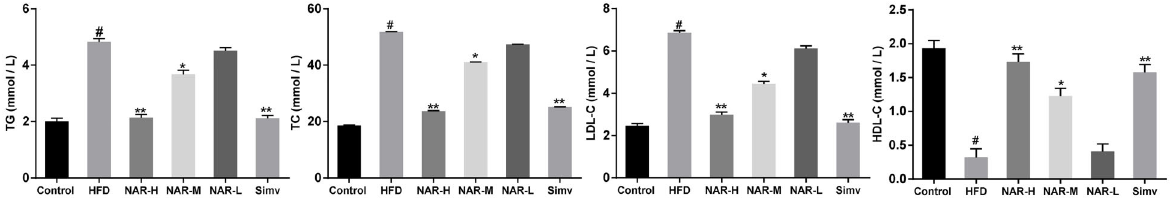
Figure 1. NAR reduced the TG, TC, and LDC-C levels but enhanced the HDL-C level in serum in HFD-induced atherosclerosis ApoE – / – mice. Data are reported as mean ± SD. # P o 0.01, *P o 0.05 compared to the control group; **P o 0.01, compared to the HFD group; n=8 (ANOVA). NAR: naringenin: high (H), medium (M), low (L); HFD: high-fat-diet; ApoE – / – : apolipoprotein E-knockout; Simv: simvastatin; TG: tri-glyceride; TC: total cholesterol; LDL-C: low density lipoprotein cholesterol; HDL-C: high density lipoprotein